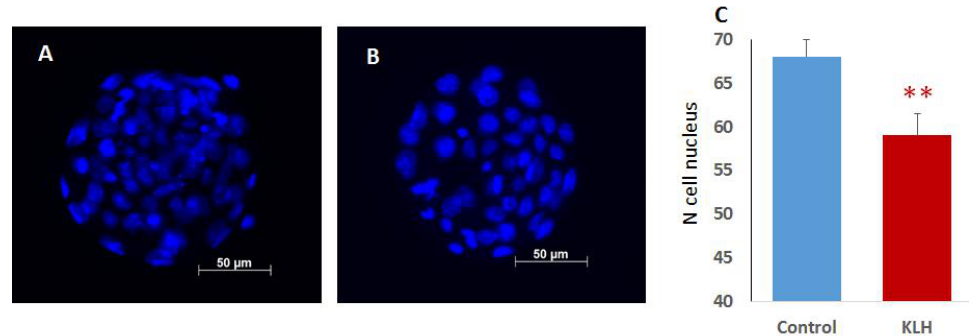
Figure 2. The number of cells (nuclei) in blastocysts of the control and KLH groups. ( A , B ) Representative blastocysts of the control ( A ) and KLH ( B ) groups stained by Hoechst-33342. ( C ) The number of nuclei that differed significantly between groups. ** p < 0.01, Student’s t -test.